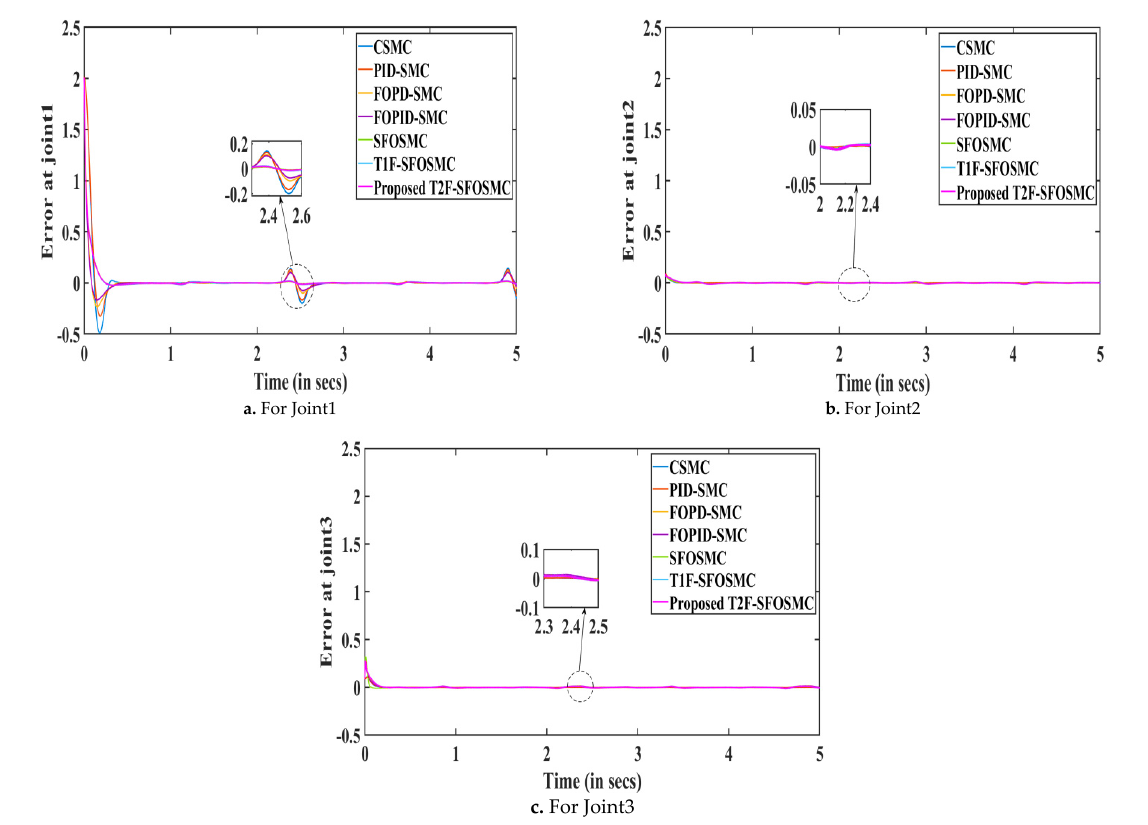
Figure 10. Trajectory tracking errors of the 3DOF surgical manipulator at Joint1, Joint2 and Joint3.